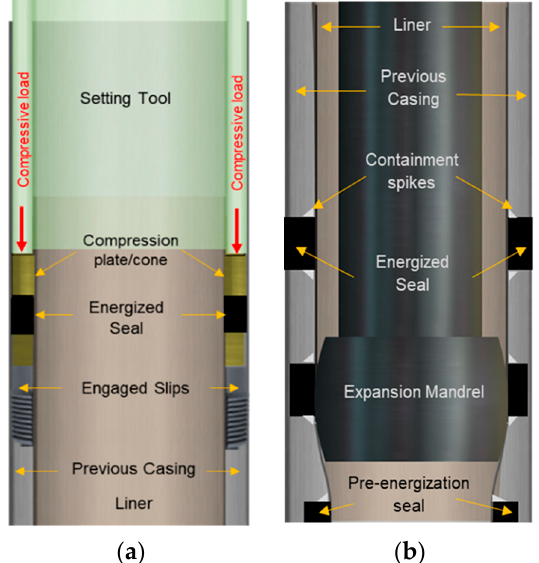
Figure 1. Schematic of ( a ) typical conventional and ( b ) expandable type hanger seal assemblies.